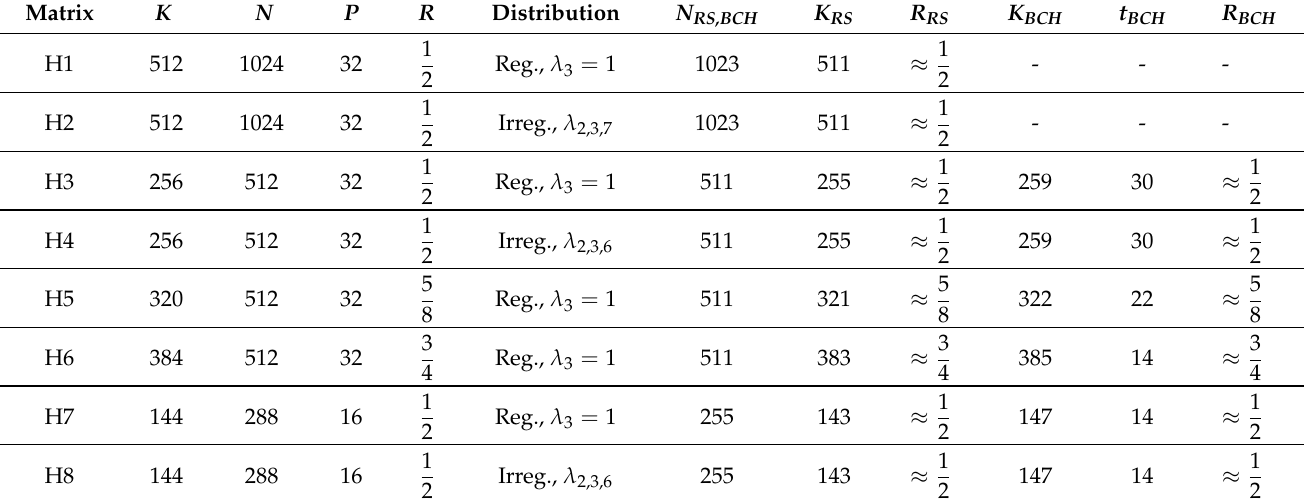
Table 2. Parameters of the experimental parity-check matrices H for LDPC. The λ d represents the fraction of degree- d variable nodes in the code